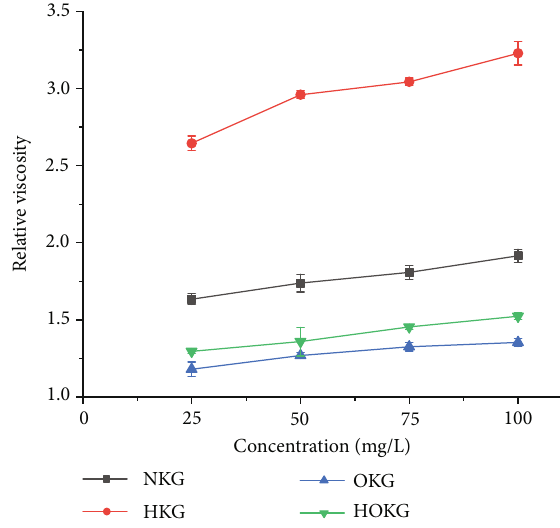
Figure 5: Relative viscosity of KG solutions at room